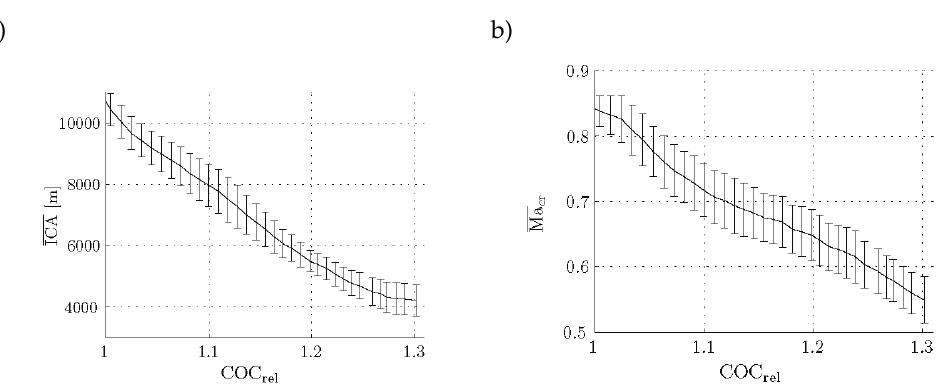
Figure 10. Mean ICA ( a ) and Ma cr ( b ) with corresponding standard deviation interval as a function of COC rel .